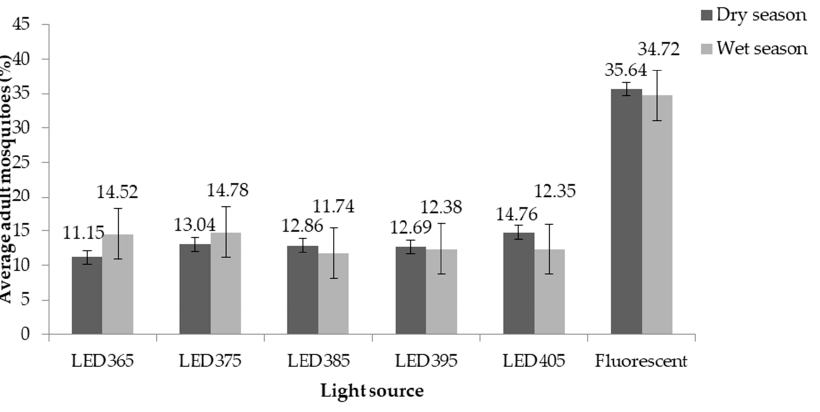
Figure 2. Percentage of mosquitoes trapped using different light source traps between dry and wet seasons.